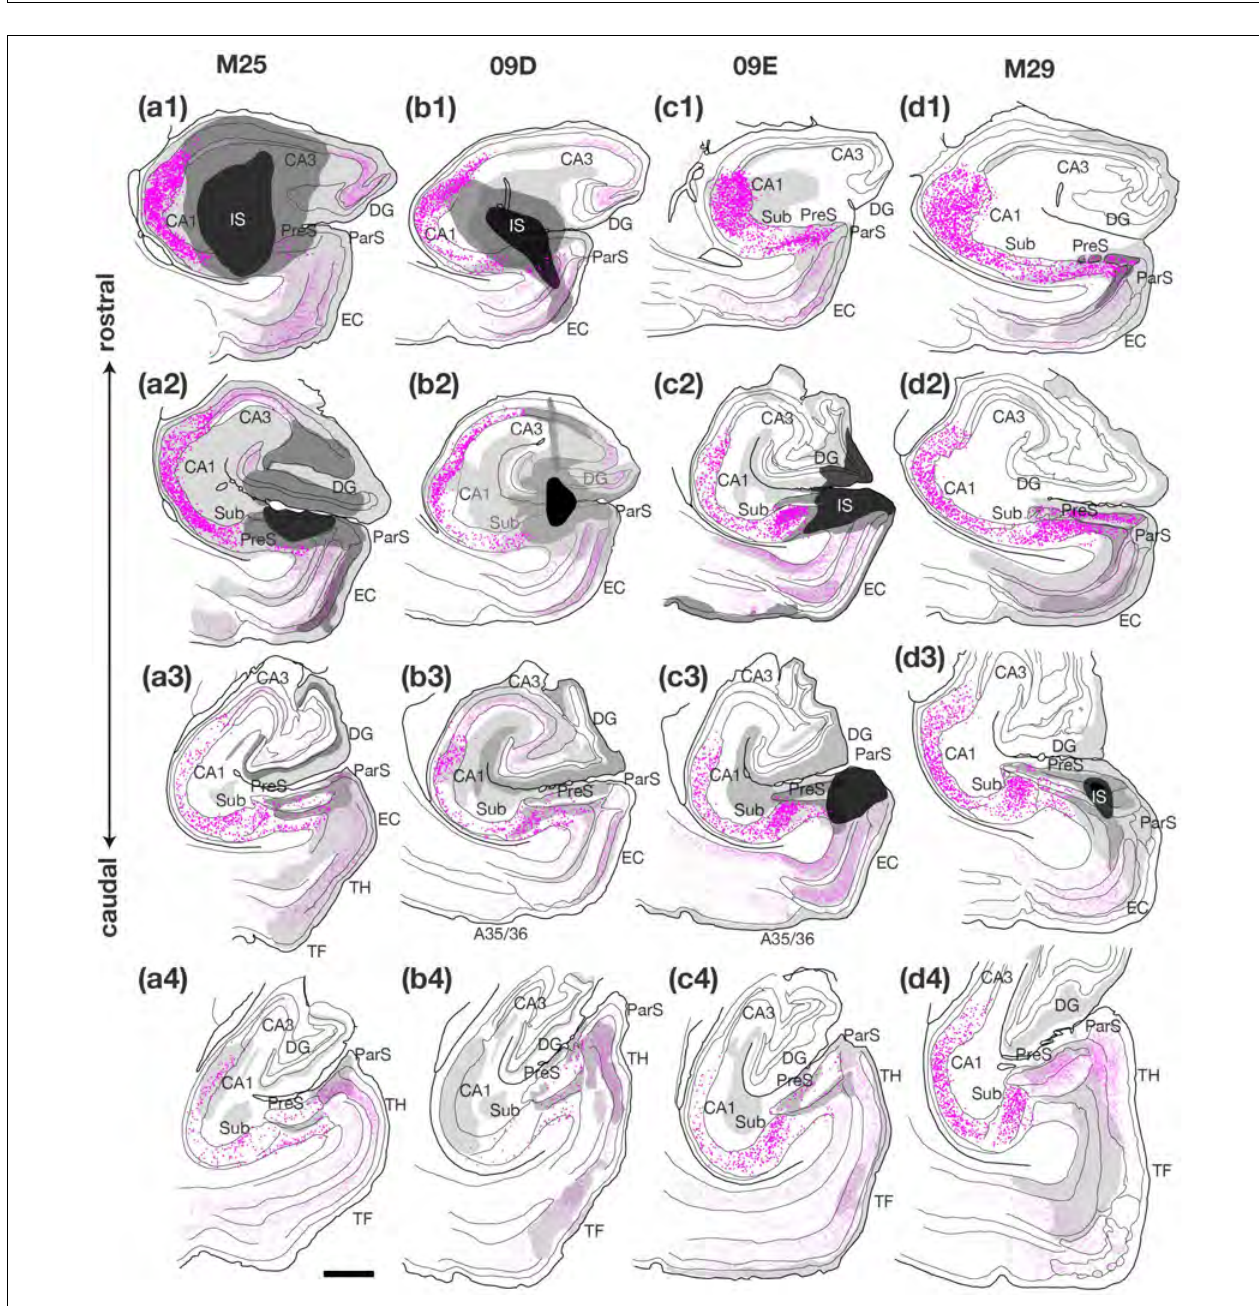
FIGURE 2 | dash lines in the unfolded map of cases M29, M27, and 10F indicate the rostrocaudal level of each panel in Figure 4 . Areas of shaded lines in cases M25, 09D, and 10F indicate the rostrocaudal levels of sections with lost parts. IS, injection site. Right histograms: Labeled-cell numbers in the pyramidal cell layer of CA1 (magenta bar) and Sub (blue bar) of each brain section are rostrocaudally aligned along the same y-axis as unfolded map. Magenta and blue cubes indicate the portions that overlapped with the center of diffusion of the injection site, and thus, accurate counting of the cell number was partially difficult within these portions. The bar graphs within cubes represent the number of cells that could be counted. Cubes of shaded lines in cases M25, 09D, and 10F indicate the rostrocaudal levels of sections with lost parts. A35/36, areas 35 and 36 (the perirhinal cortex); CA, cornu ammonis; DG, dentate gyrus; EC, entorhinal cortex; IS, injection site; ParS, parasubiculum; PreS, presubiculum; Sub, subiculum; TF, area TF; TH, area TH. Note that many CA1 cells were retrogradely labeled along the rostrocaudal axis in the experimental cases where CTB injection extended to all layers of PreS (cases M25, 09D, 09E, M29, and M27). On the other hand, fewer labeled cells